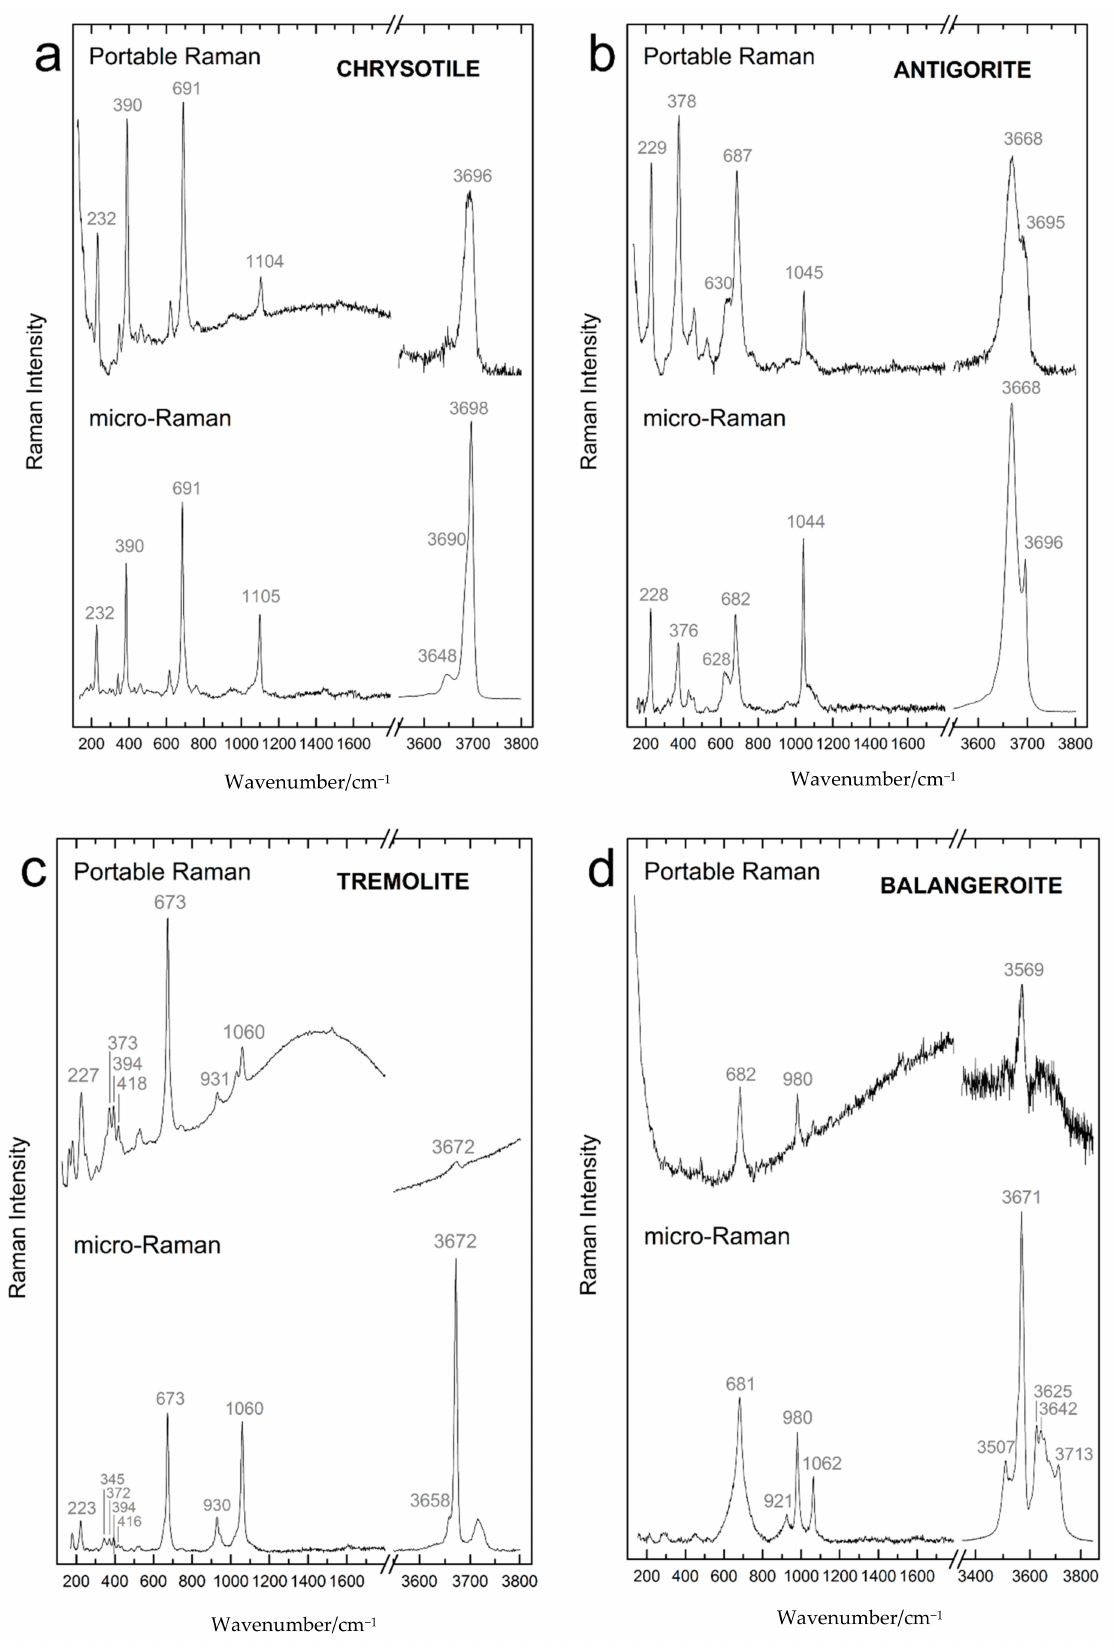
Figure 4. Comparison of Raman spectra of ( a ) chrysotile; ( b ) antigorite; ( c ) tremolite, and ( d ) balangeroite collected with portable Raman (on the top) and micro-Raman spectrometer (on the